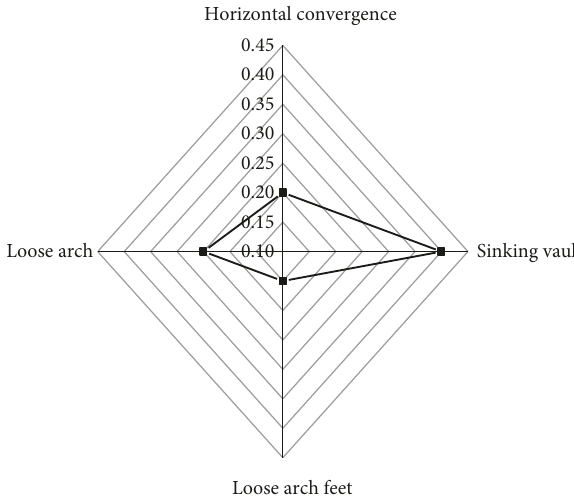
Figure 9: Weight of the optical explosion inspection